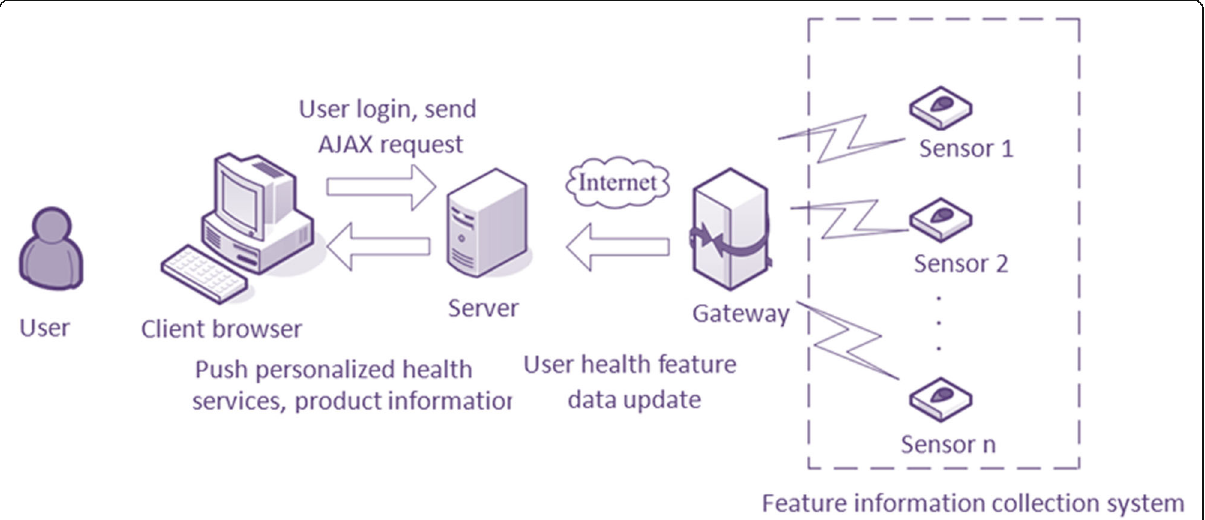
Fig. 7 Network architecture diagram of a consumer intelligent push system based on a wireless sensing